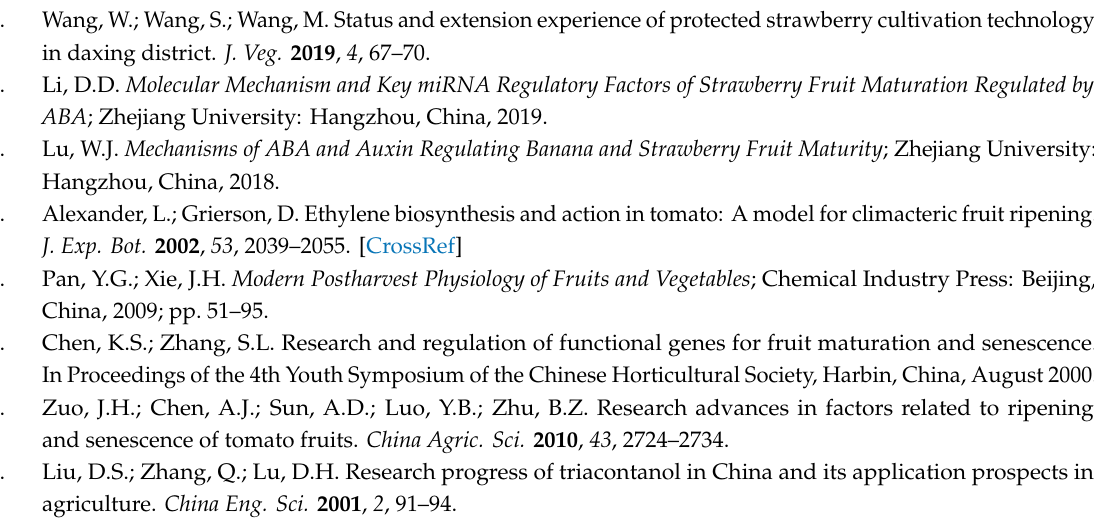
Table S1: High-quality sequence reads, Table S2: The number of genes in di ff erent expression level, Table S3: The identified di ff erentially expressed genes, Table S4: GO enrichment of DEGs, Table S5: KEGG enrichment pathways of DEGs, Table S6: TF. family.